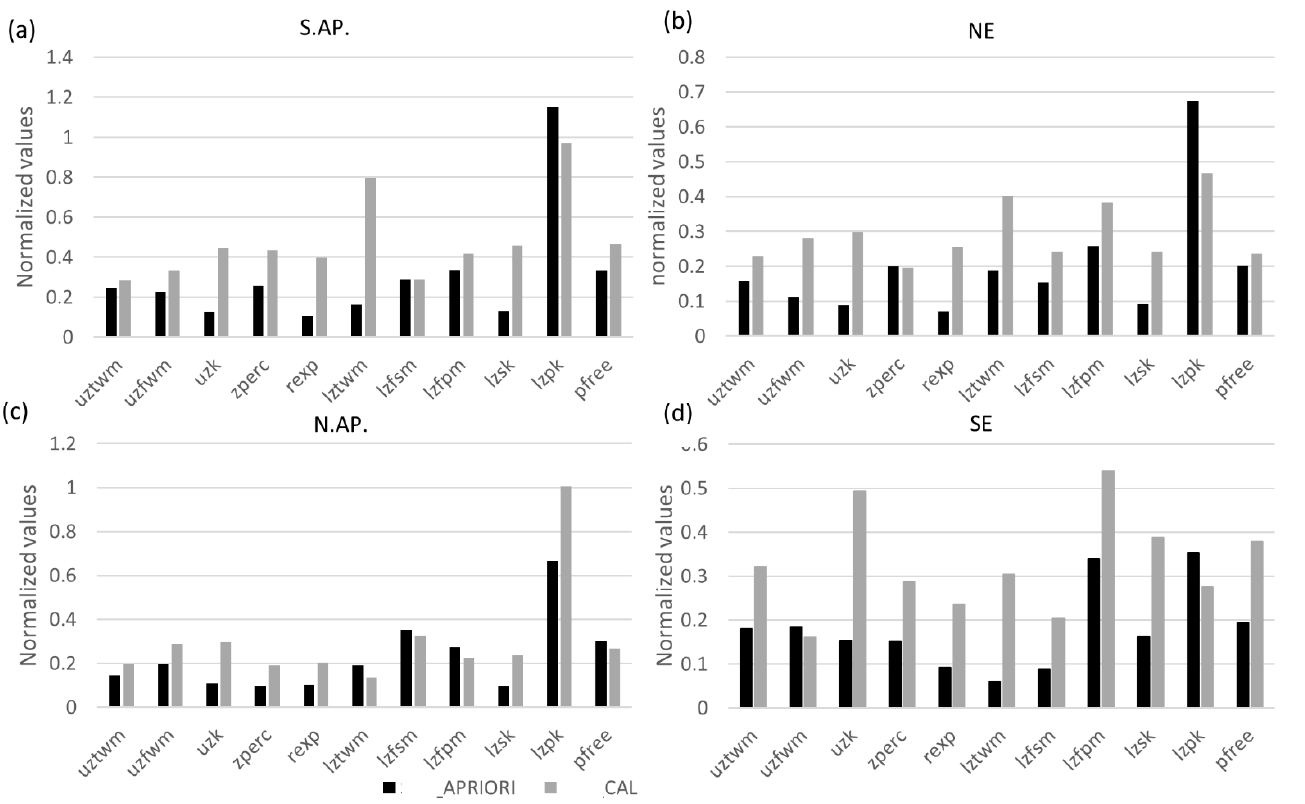
Figure 7. The parameters variability in each region refers to the normalized standard deviations of each parameter by the median of parameters standard deviation in the study region during APRIORI and CAL simulations, respectively. Please refer to Table 2 and Figure 3 for the meaning of each model parameter in Figures ( a – d